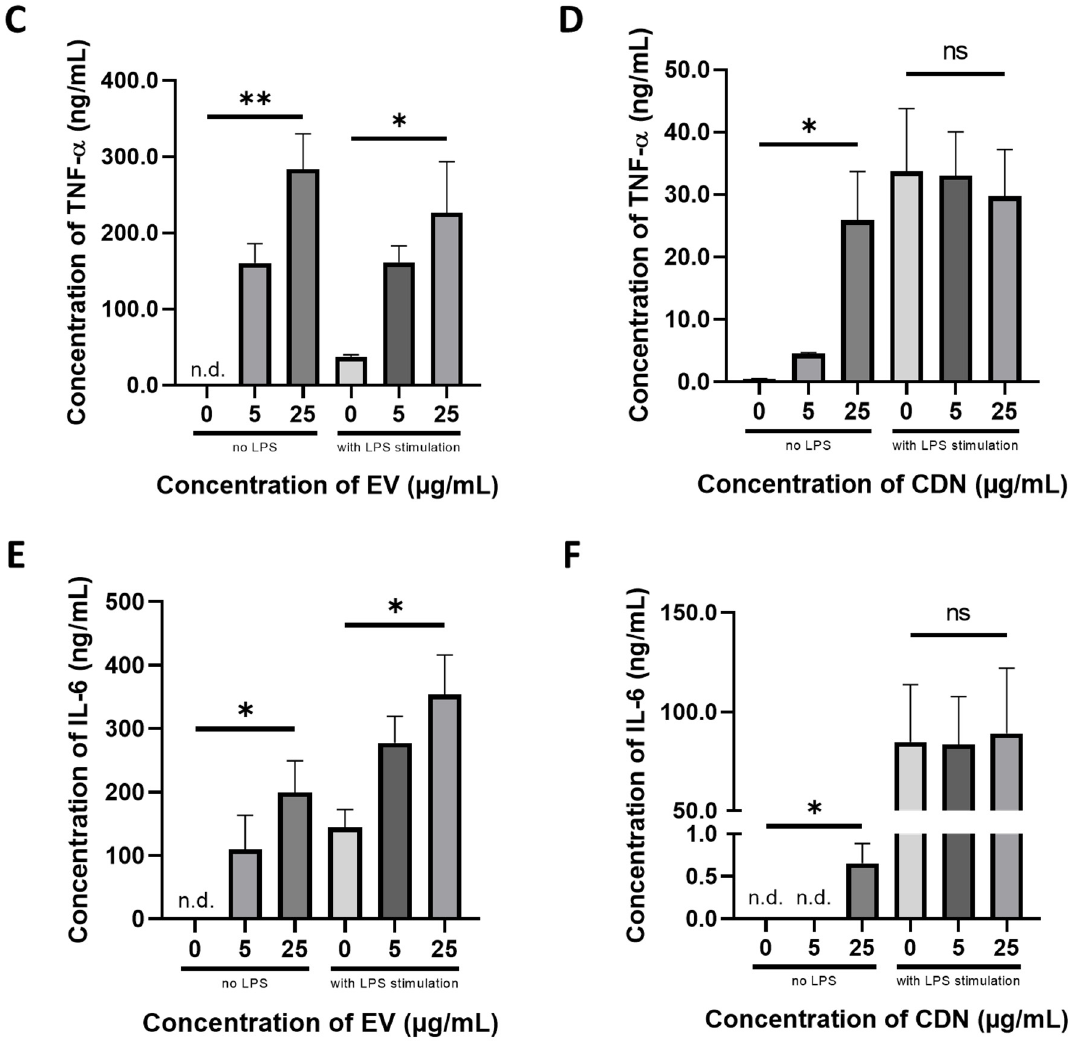
Figure 4. Nitrite concentrations in cell culture supernatant after RAW264.7 macrophages had been treated with increasing concentrations of ( A ) U937 EVs and ( B ) CDNs for 24 h. TNF- α concentrations in cell culture supernatant after RAW264.7 macrophages were treated with increasing concentrations of ( C ) U937 EVs and ( D ) CDNs for 24 h. IL-6 concentrations in the cell culture supernatant after RAW264.7 macrophages were treated with increasing concentrations of ( E ) U937 EVs and ( F ) CDNs for 24 h. IL-1 β and IL-10 concentrations were below the detection limit of the ELISA kits (<31.3 pg/mL). The LPS concentration was 10 ng/mL. Data are presented as mean ± SEM ( n = 3). n.s., no statistical di ff erence; *, p < 0.05, **, p < 0.01; ***, p < 0.001.